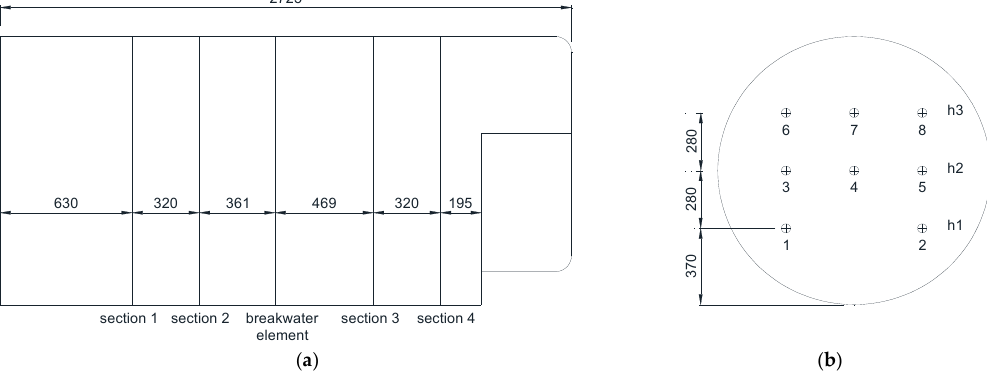
Figure 2. ( a ) Left. Cross-sections of velocity measurement points inside the tank (dimensions in millimeters); ( b ) Right. Velocity measurement points within each of the four sections.